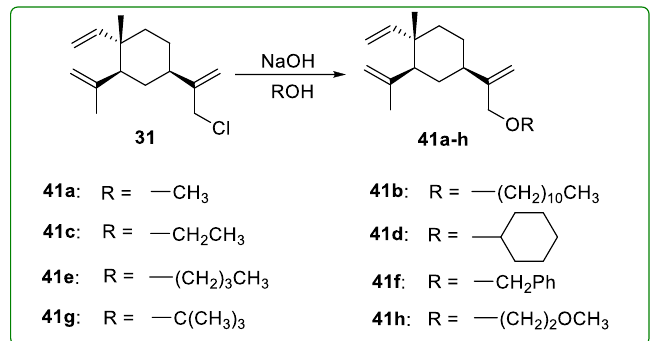
Figure 12. Chemical structures of β -elemene ether derivatives 41a – h